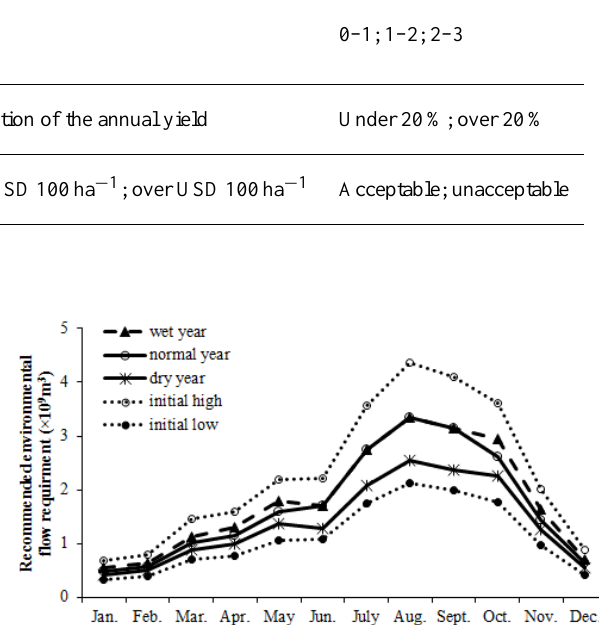
Fig. 8. The recommended environmental flow in dry, normal, and wet